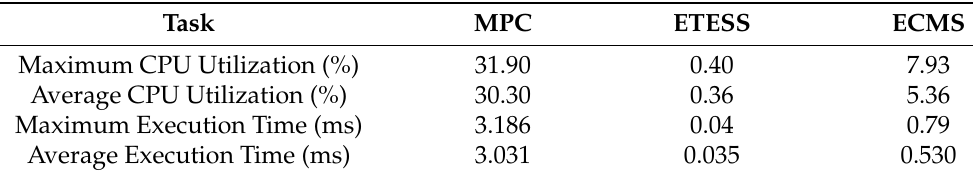
Table 6. PIL testing results in the worst test case.